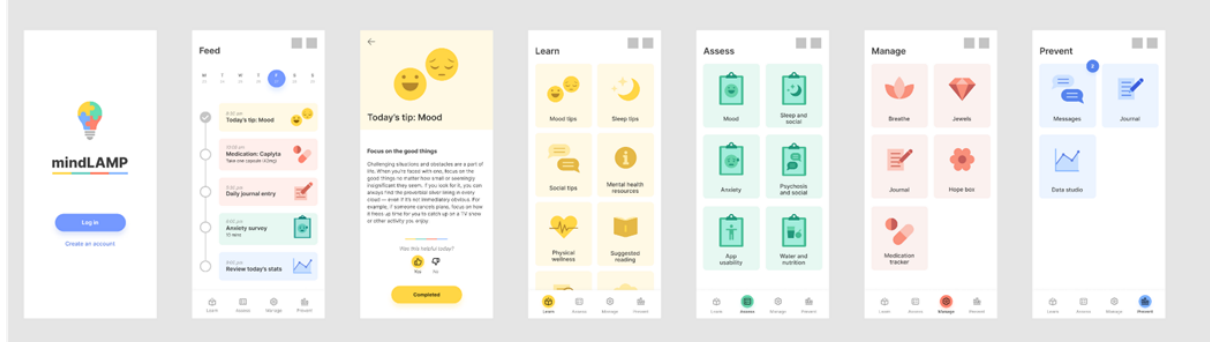
Figure 3. Screenshots of mindLAMP showing the Learn, Assess, Manage, and Prevent